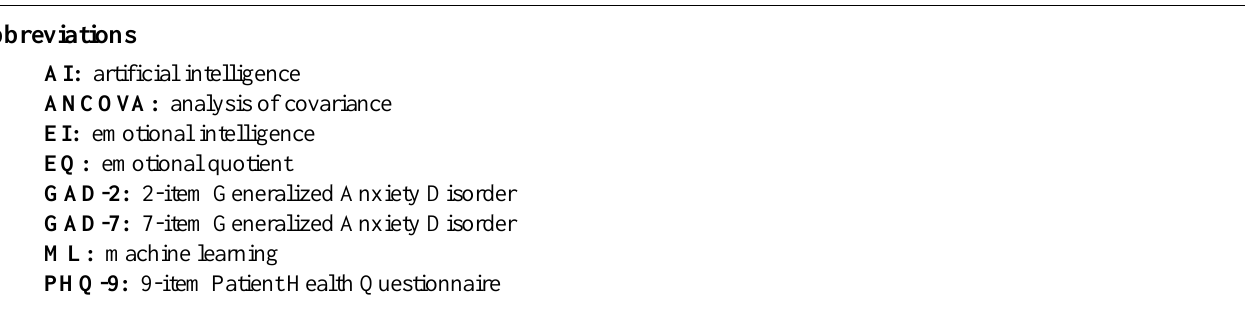
PHQ-9: 9-item Patient Health